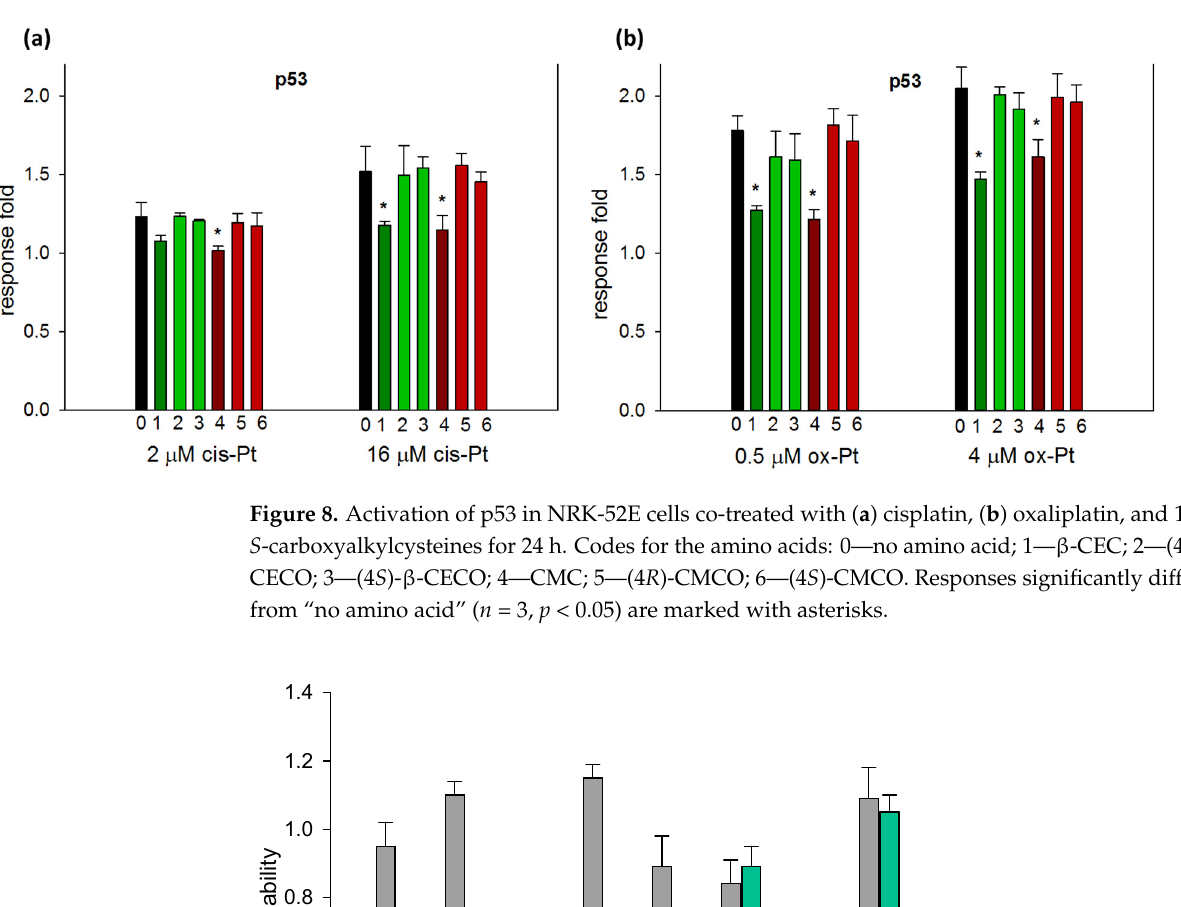
Figure 8. Activation of p53 in NRK-52E cells co-treated with ( a ) cisplatin, ( b ) oxaliplatin, and 1 mM S -carboxyalkylcysteines for 24 h. Codes for the amino acids: 0—no amino acid; 1— β -CEC; 2—(4 R )- β -CECO; 3—(4 S )- β -CECO; 4—CMC; 5—(4 R )-CMCO; 6—(4 S )-CMCO. Responses significantly dif- ferent from “no amino acid” ( n = 3, p < 0.05) are marked with asterisks.